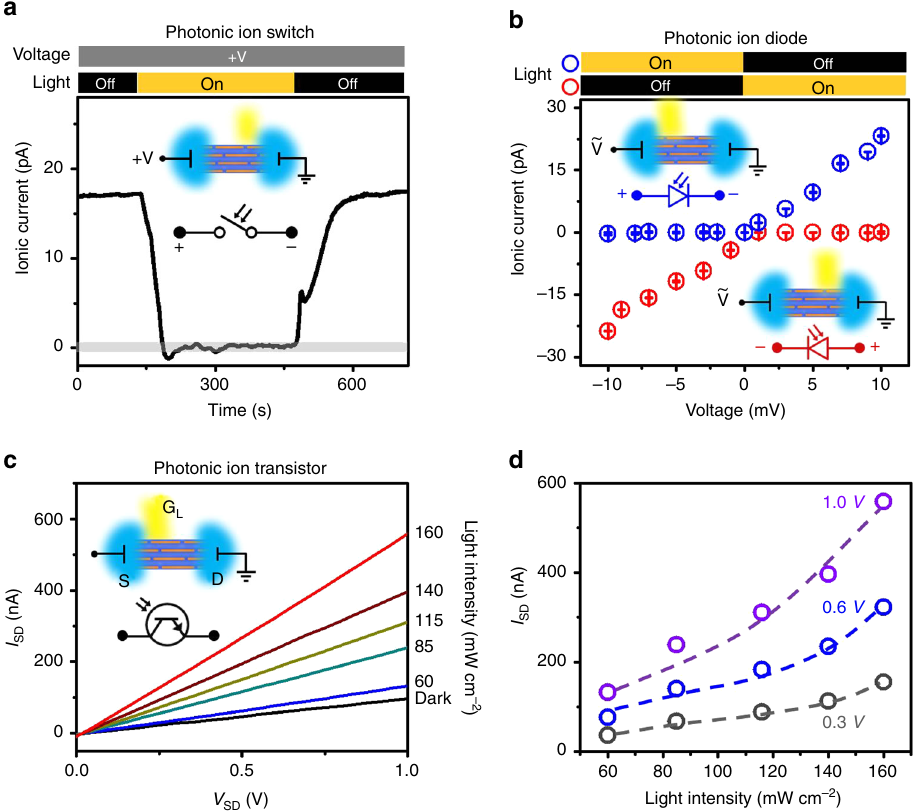
Fig. 4 Photonic nano fl uidic devices. a Photonic ion switch (PIS). Asymmetric light illumination (~150 mWcm − 2 ) on GO strip perfectly switches off the